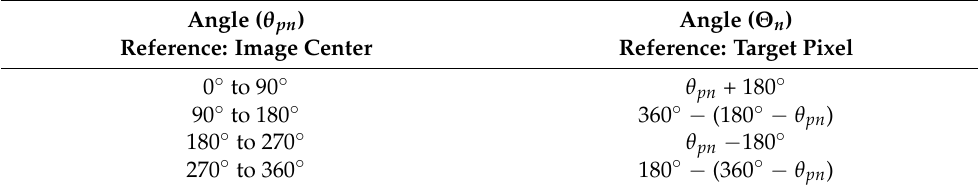
Table 5. Relation between image center and target pixel reference